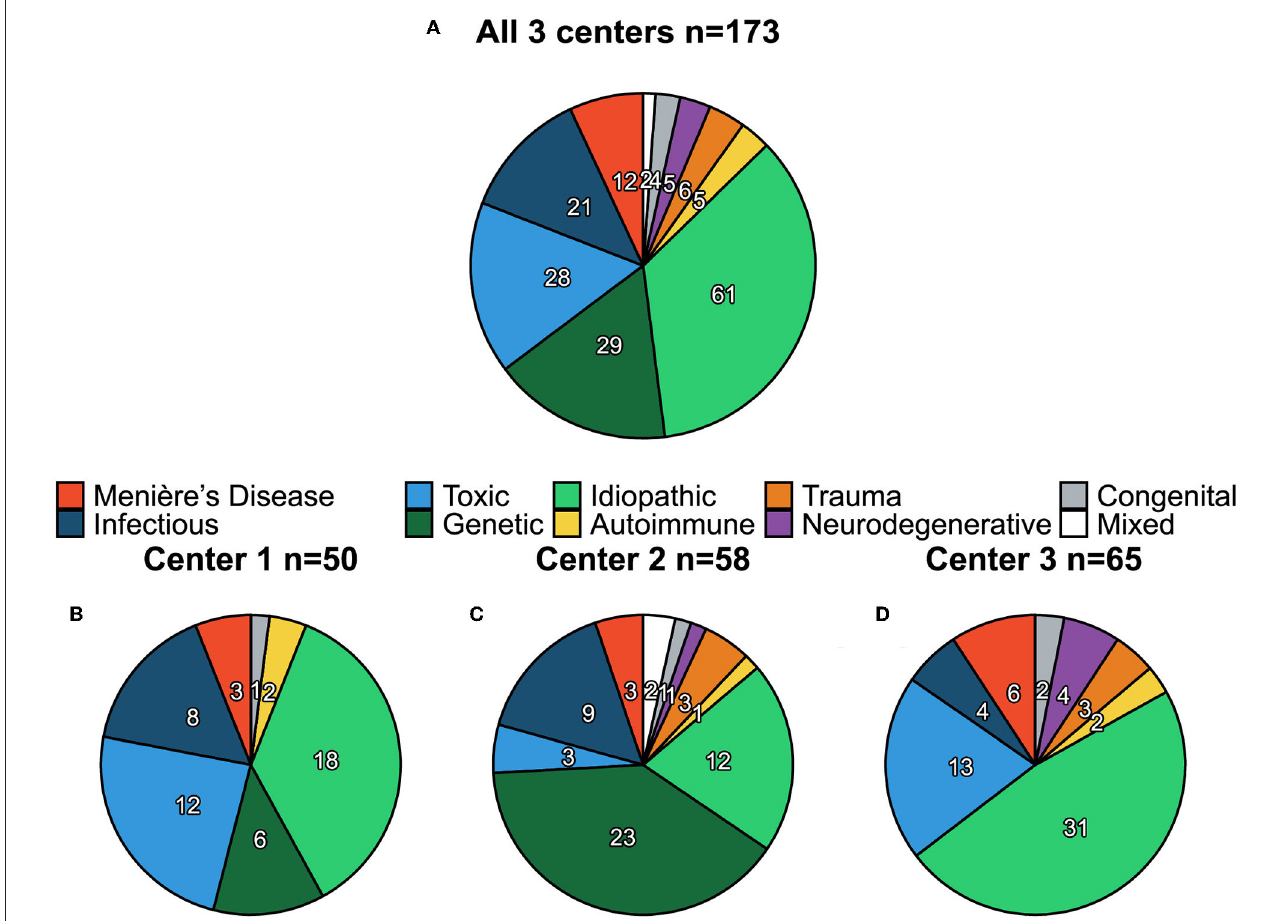
FIGURE 1 | Distribution of etiology of bilateral vestibulopathy (BVP) for all three centers combined (A) and per center separately (B–D) . Numbers shown in each pie chart represent the count ( n ) of each